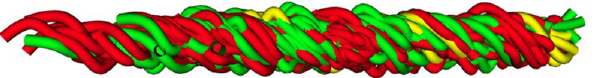
Figure 12. Ply staple yarn